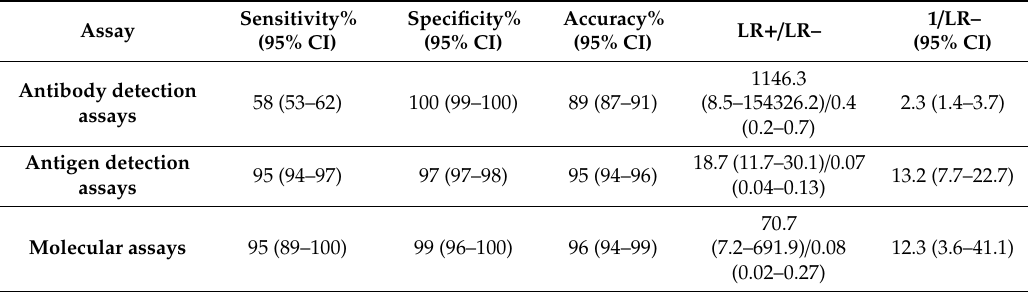
Table 1. Summary of the meta-analysis of the analytical performance of the assays for the diagnosis of PDH in